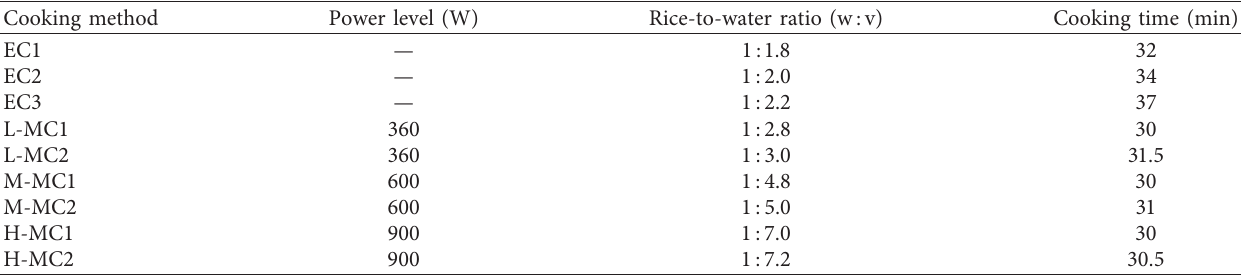
Table 1: Experimental conditions for rice